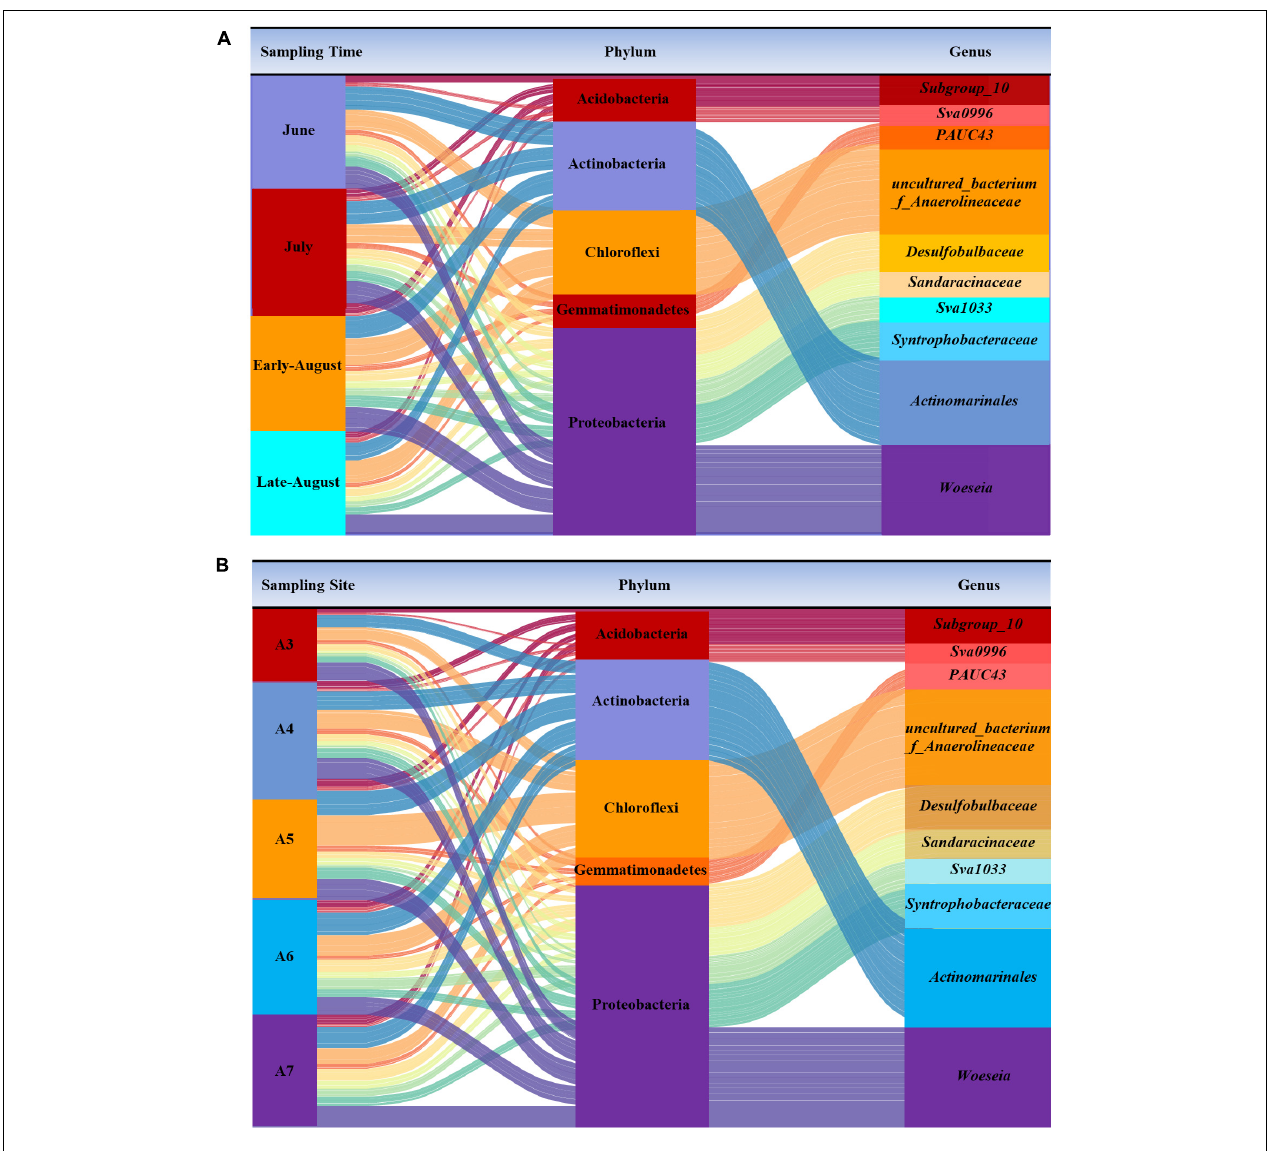
FIGURE 2 | The community composition of dominant bacteria at phylum and genus level from each sampling time (A) and site (B)